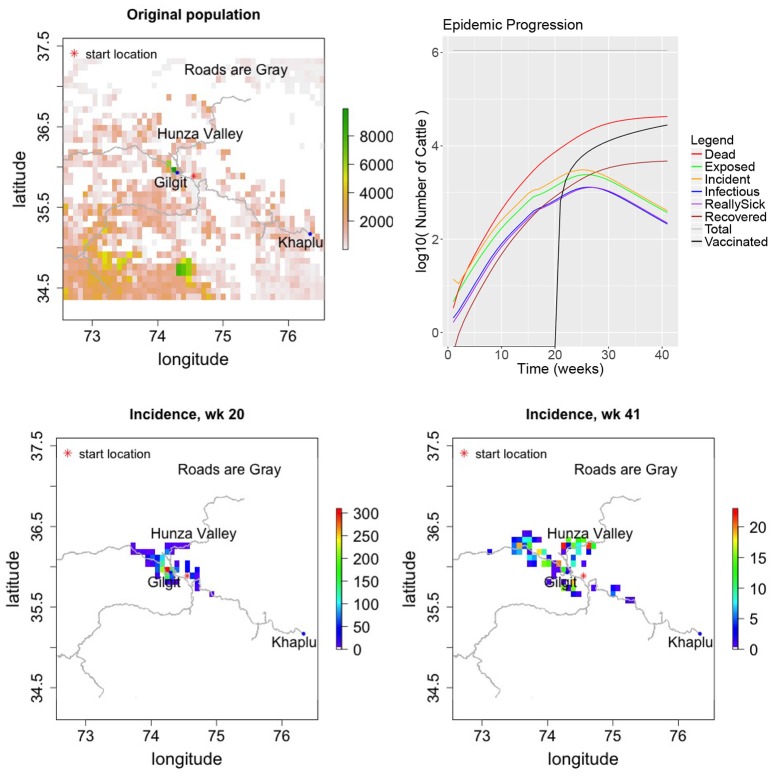
Results of simulating the 1994–1995 rinderpest outbreak in Pakistan.